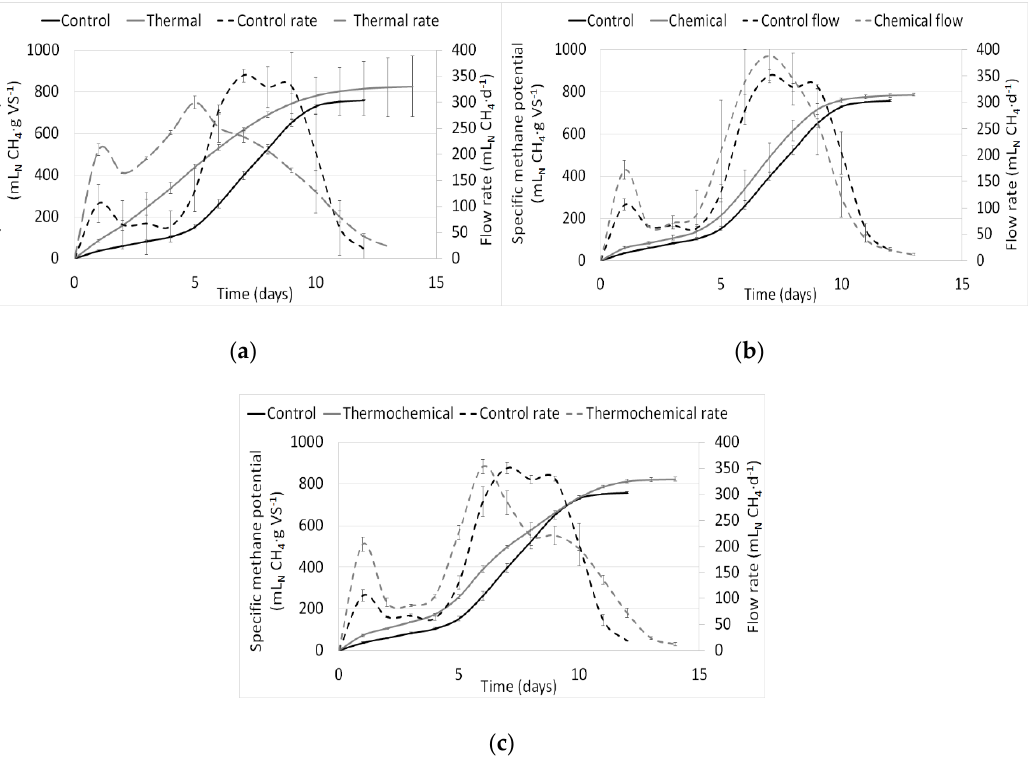
Figure 5. Specific methane potentials and production rates of: ( a ) thermally treated dissolved air flotation (DAF) sludge from a red meat processor [42]; ( b ) chemically treated DAF sludge [42]; ( c ) thermos-chemically treated DAF sludge [42]. Error bars represent one standard deviation from the mean.